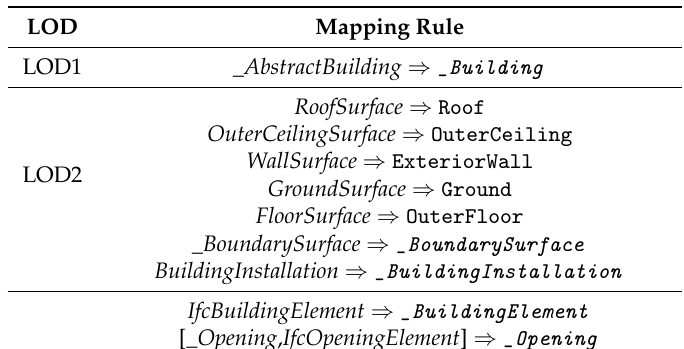
Table 1. Transformation rules from IFC & CityGML to